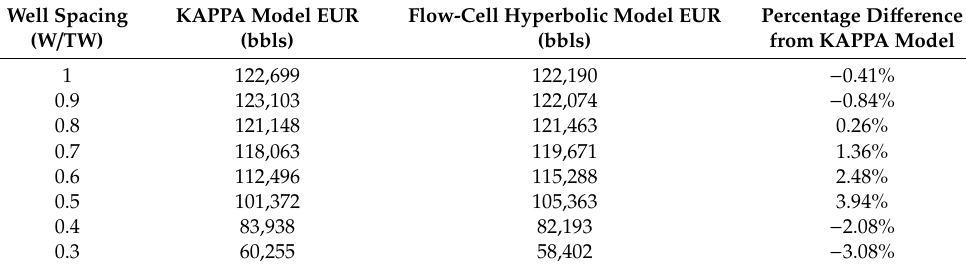
Table5. EURComparison betweenKAPPA andHyperbolic Flowcell model(DOI frac-tipkick-o ff times). Well Spacing KAPPA Model EUR Flow-Cell Hyperbolic Model EUR Percentage Di ff (W / TW) (bbls) (bbls)